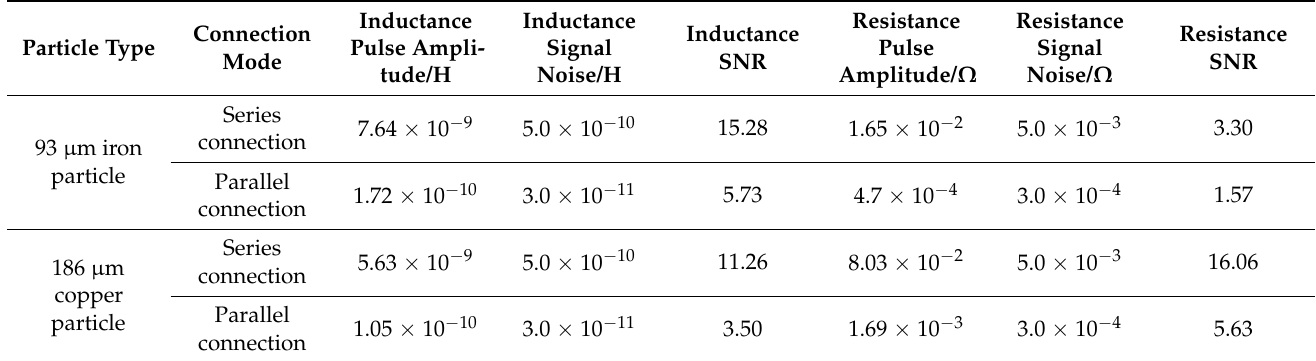
Table 2. Detection results of the sensor with silicon steel